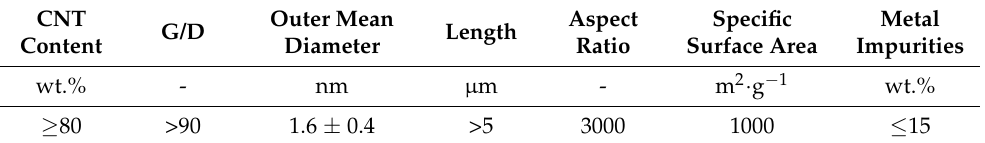
Table 1. Single-walled carbon nanotube (SWCNT) specification and structure parameters (provided by OCSIAL).